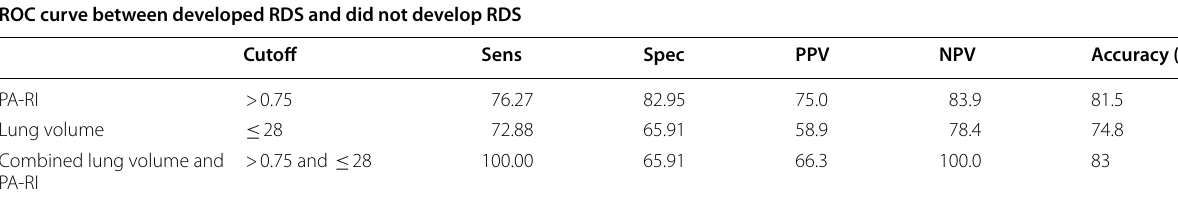
Table 4 Receiver operating characteristic curves (ROC) between developed RDS and did not develop RDS ROC curve between developed RDS and did not develop RDS